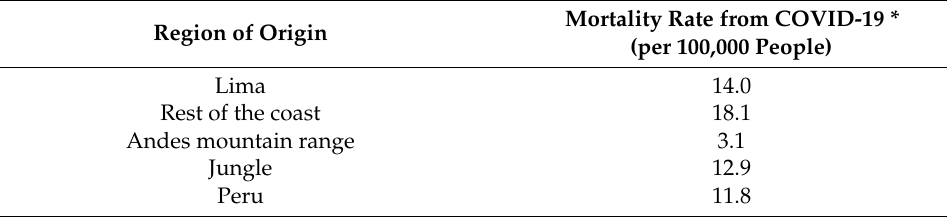
Table 2. The mortality rate from COVID-19 by region of Peru from March 28 to 21 May 2020. Region of